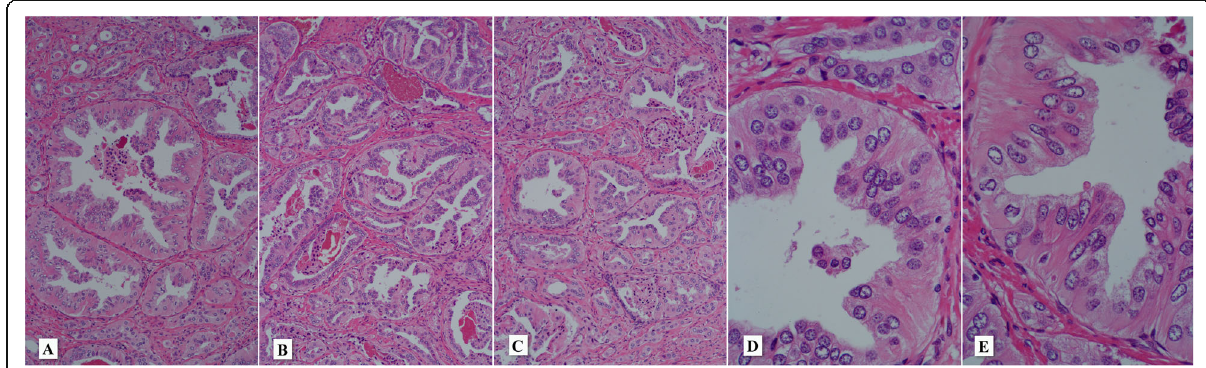
Fig. 1 Invasive prostatic adenocarcinoma with pseudohyperplastic morphology and inverse polarity. See nuclei arranged towards the lumen. Microscopic architecture is very reminiscent of high-grade prostatic neoplasia with inverted polarity. Hematoxylin and eosin stain: A,B and C (40x) and D and C (400x)